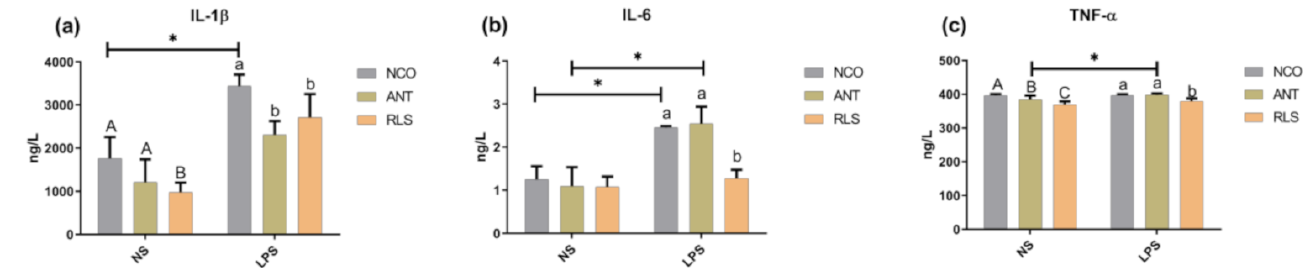
Figure 3. Effects of RLS on serum inflammatory factors in broilers challenged with LPS. ( a ) Effect of RLS on IL-1 β . ( b ) Effect of RLS on IL-6. ( c ) Effect of RLS on TNF- α . NS-NCO represents control broilers treated with normal saline; NS-ANT represents broilers treated with the antibiotic; NS-RLS represents broilers treated with rhamnolipids; LPS-NCO represents control broilers challenged with LPS; LPS-ANT represents broilers treated with the antibiotic and challenged with LPS; LPS-RLS represents broilers treated with rhamnolipids and challenged with LPS; * and different superscript letters indicate significant differences ( p < 0.05), majuscule present NS-groups and lowercase present LPS-groups, n = 6.